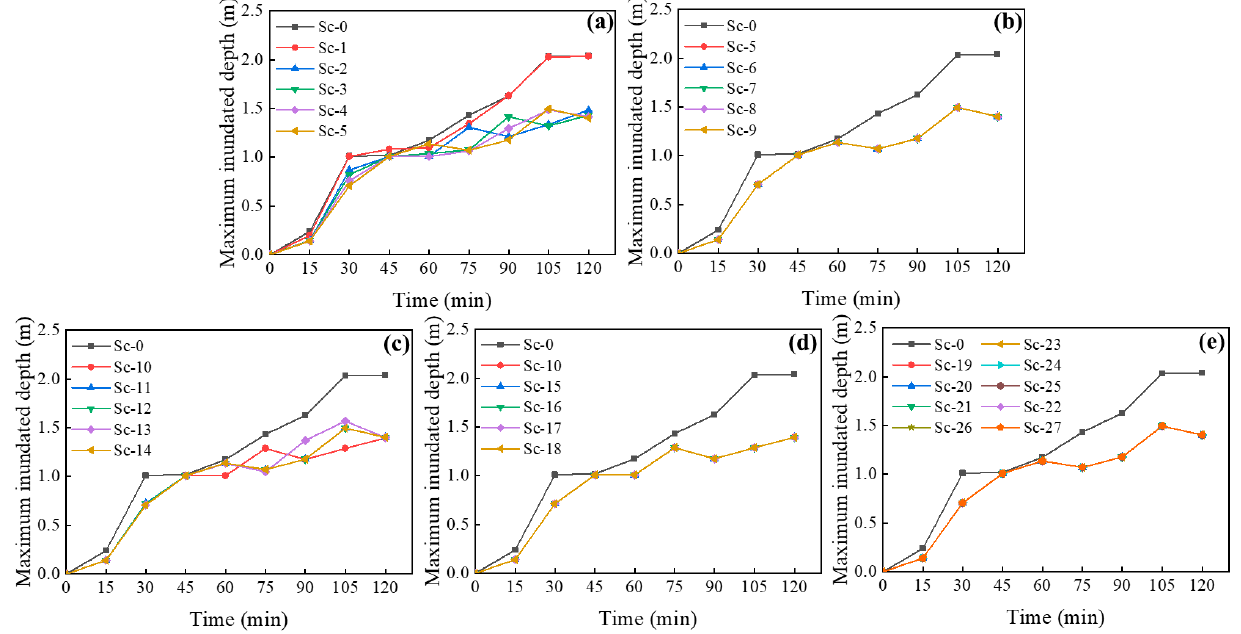
Figure 21. The time series plot of MID in 3 h event in considered scenarios of ( a ) connectedness of GR; ( b ) connectedness of RG; ( c ) edge density of GR; ( d ) edge density of RG; ( e ) flow distance of RG.